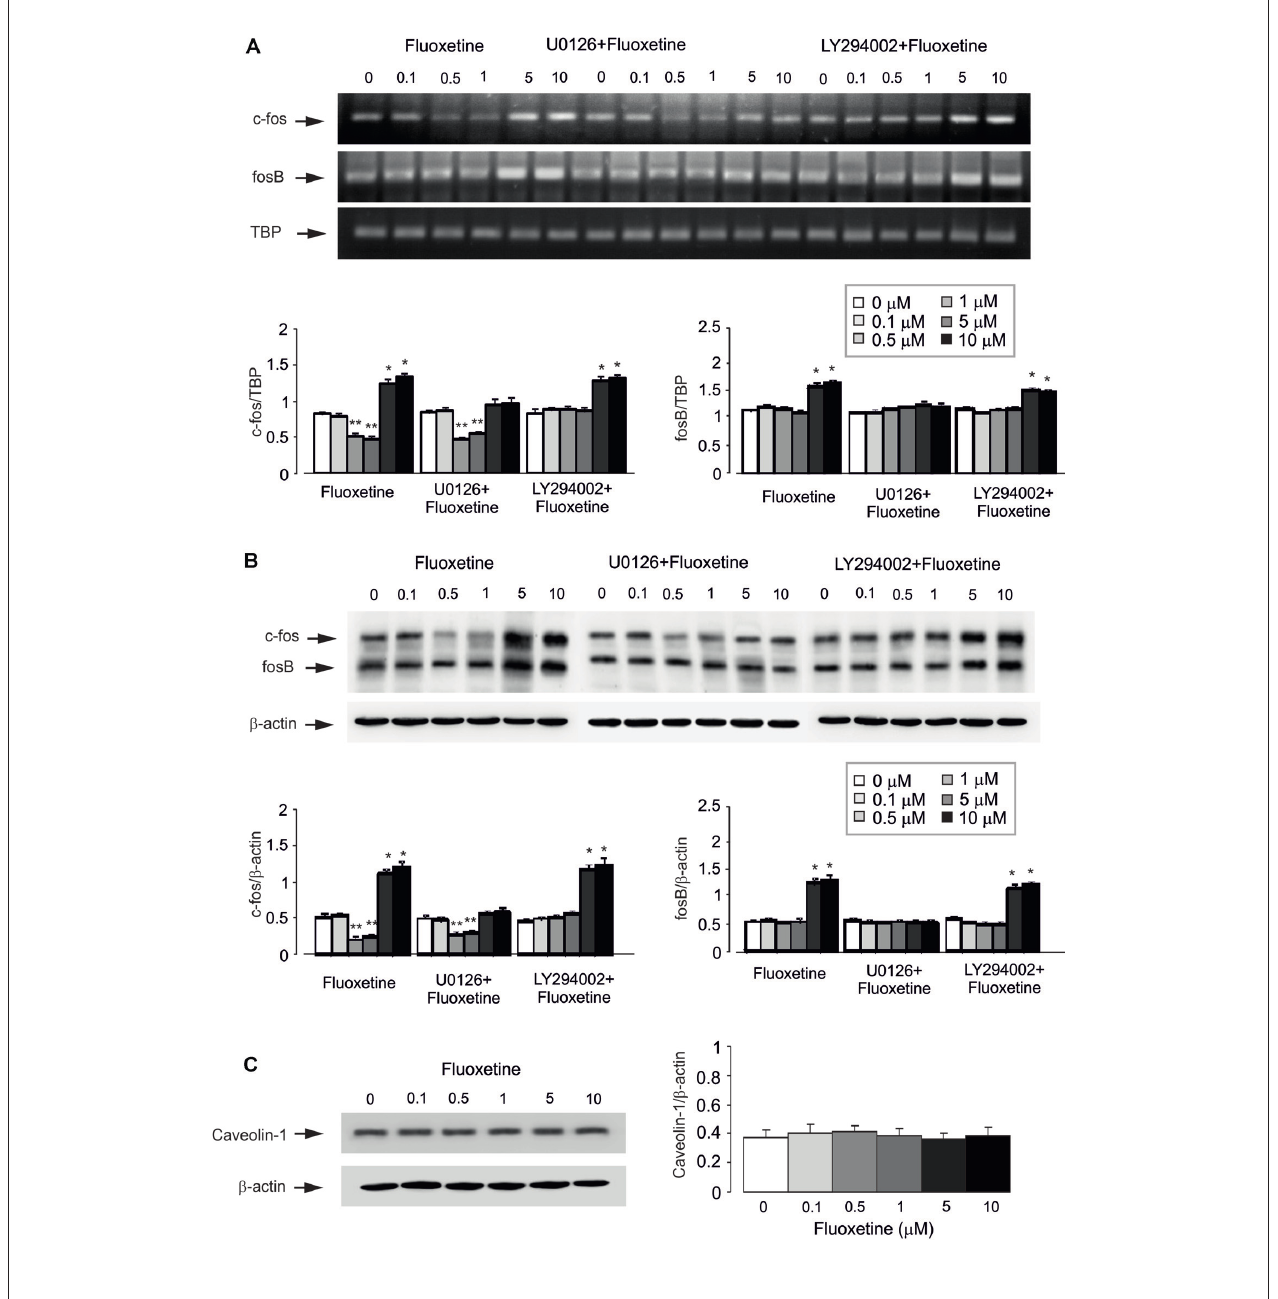
FIGURE 2 | Regulation of mRNA and protein expression of cfos and fosB or protein content of Caveolin-1 (Cav-1) by acute treatment with fluoxetine in astrocytes. (A,B) After pretreatment in serum-free medium with or without U0126, an inhibitor of MEK or LY294002, an inhibitor of PI3K for 15 min, cells were incubated for 1 or 4 h in the absence of any drug (0 µ M fluoxetine, control) or in the presence of 0.1, 0.5, 1, 5, or 10 µ M fluoxetine. (A) Southern blot from representative experiment. Similar results were obtained from three independent experiments. Average mRNA expression was quantitated as ratios between c-fos and TBP, used as a house-keeping gene and between fosB and TBP. (B) Immunoblot from a representative experiment. Similar results were obtained from three independent experiments. Average protein expression was quantitated as ratios between c-Fos and β -actin, used as a house-keeping gene and between FosB and β -actin. SEM values are indicated by vertical bars. ∗ Indicates statistically significant ( P < 0.05) difference from 0, 0.1, 0.5 and 1 µ M fluoxetine; ∗∗ indicates statistically significant ( P < 0.05) difference from all other groups but not from each other. (C) Cells were incubated for 1 or 4 h in the absence of any drug (0 µ M fluoxetine, control) or in the presence of 0.1, 0.5, 1, 5, or 10 µ M fluoxetine. Left panel shows the immunoblot from a representative experiment. Similar results were obtained from three independent experiments. Average protein expression was quantified as ratio between Cav-1 and β -actin, used as a house-keeping gene (right panel). SEM values are indicated by vertical